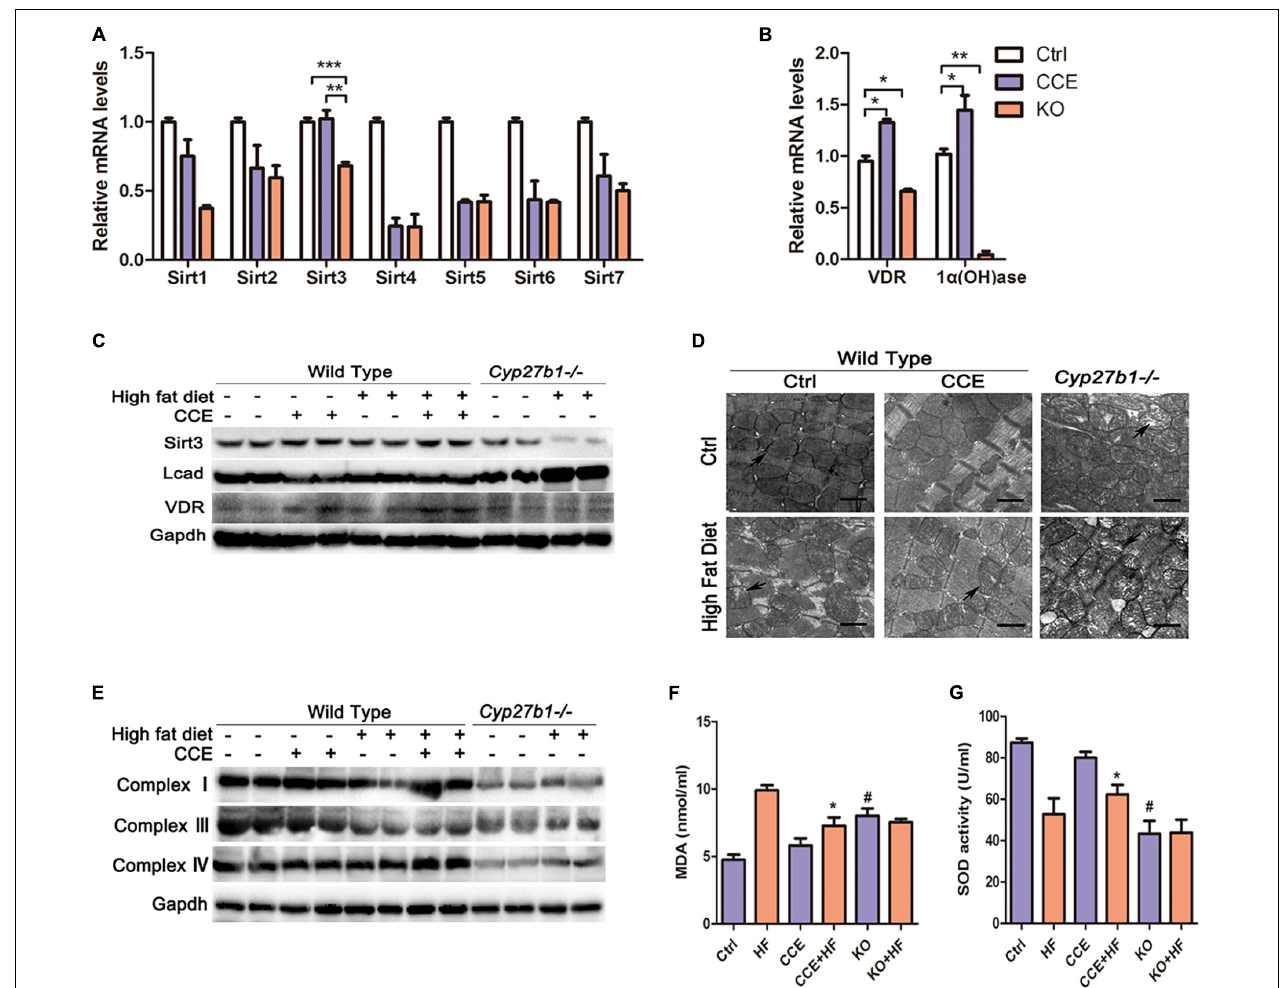
FIGURE 4 | Vitamin D increased the expression of SIRT3 and mitochondrial complexes in high-fat diet-fed mice. (A,B) RT-qPCR analysis of sirtuins, VDR, and 1 α (OH)ase revealed that the expression levels of Sirt3 , VDR , and 1 α (OH)ase were decreased in the KO group and increased following CCE treatment. Values are expressed as the mean ± SEM, * p < 0.05, ** p ≤ 0.01, and *** p ≤ 0.001. (C) Western blotting analysis of SIRT3, LCAD, and VDR protein levels. (D) Electron microscopy images indicated mitochondrial arrangement and morphological characteristics (12,000 × ). Aberrant mitochondrial structures are indicated by a